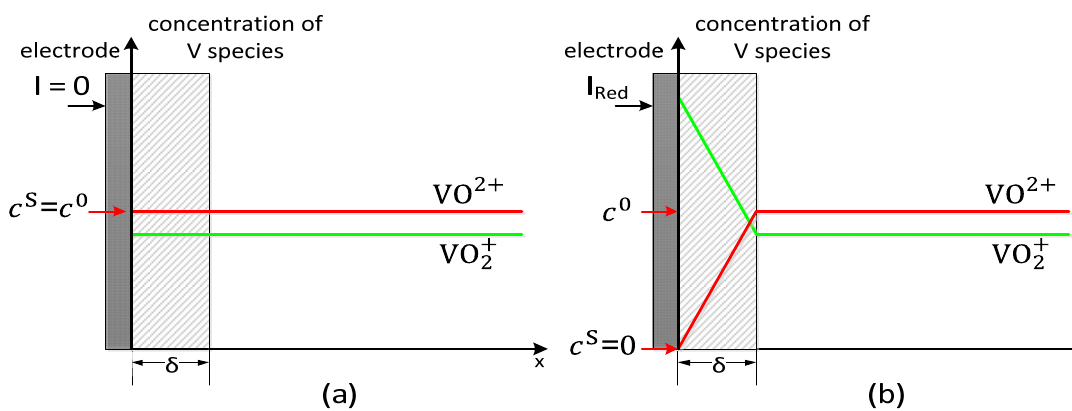
Figure 1. Concentration profile in the diffusion layer in front of the electrode in the positive electrolyte, without current ( a ) and with applied reduction current ( b ).